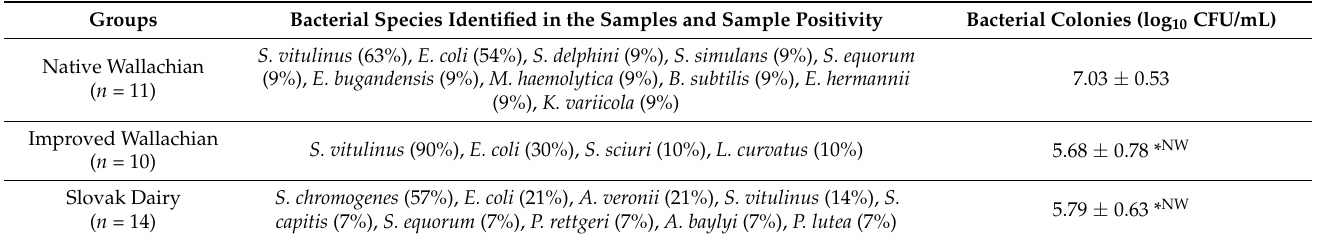
Table 1. Bacterial profiles of ram semen samples according to the breed.